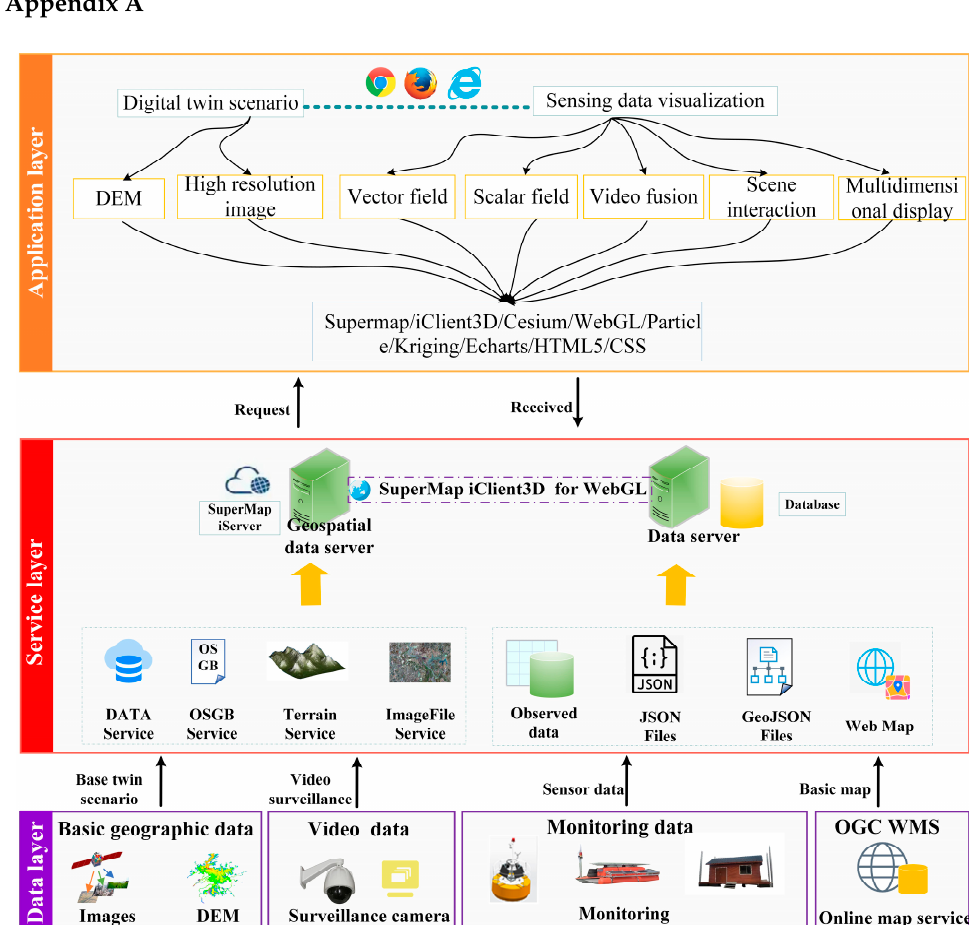
Figure A1. System architecture of the Poyang Lake digital twin world system.